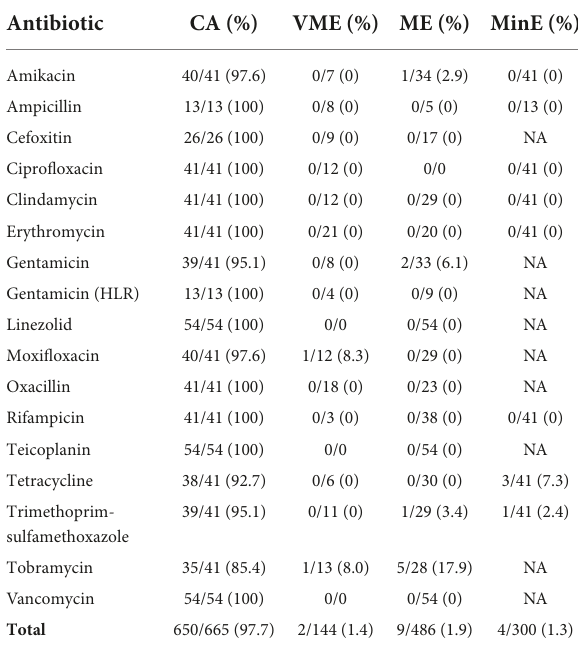
TABLE 2 Results from automated AST (BD Phoenix TM System) of 54 staphylococci and enterococci from a liquid colony following FAST TM System testing on positive blood cultures in both study arms